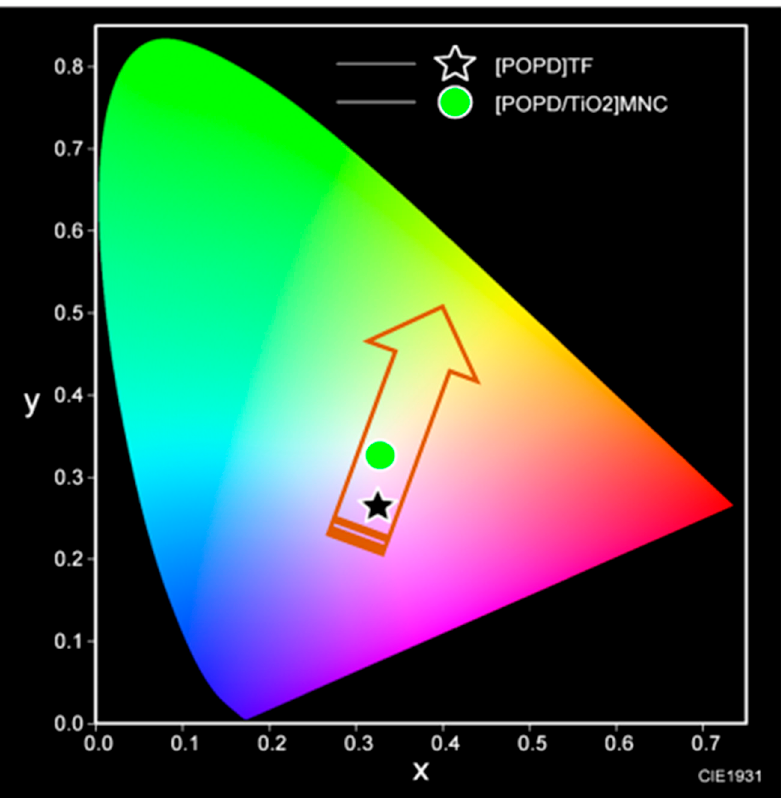
TF and [PoPDA/TiO MNC thin films at 298 2 ]